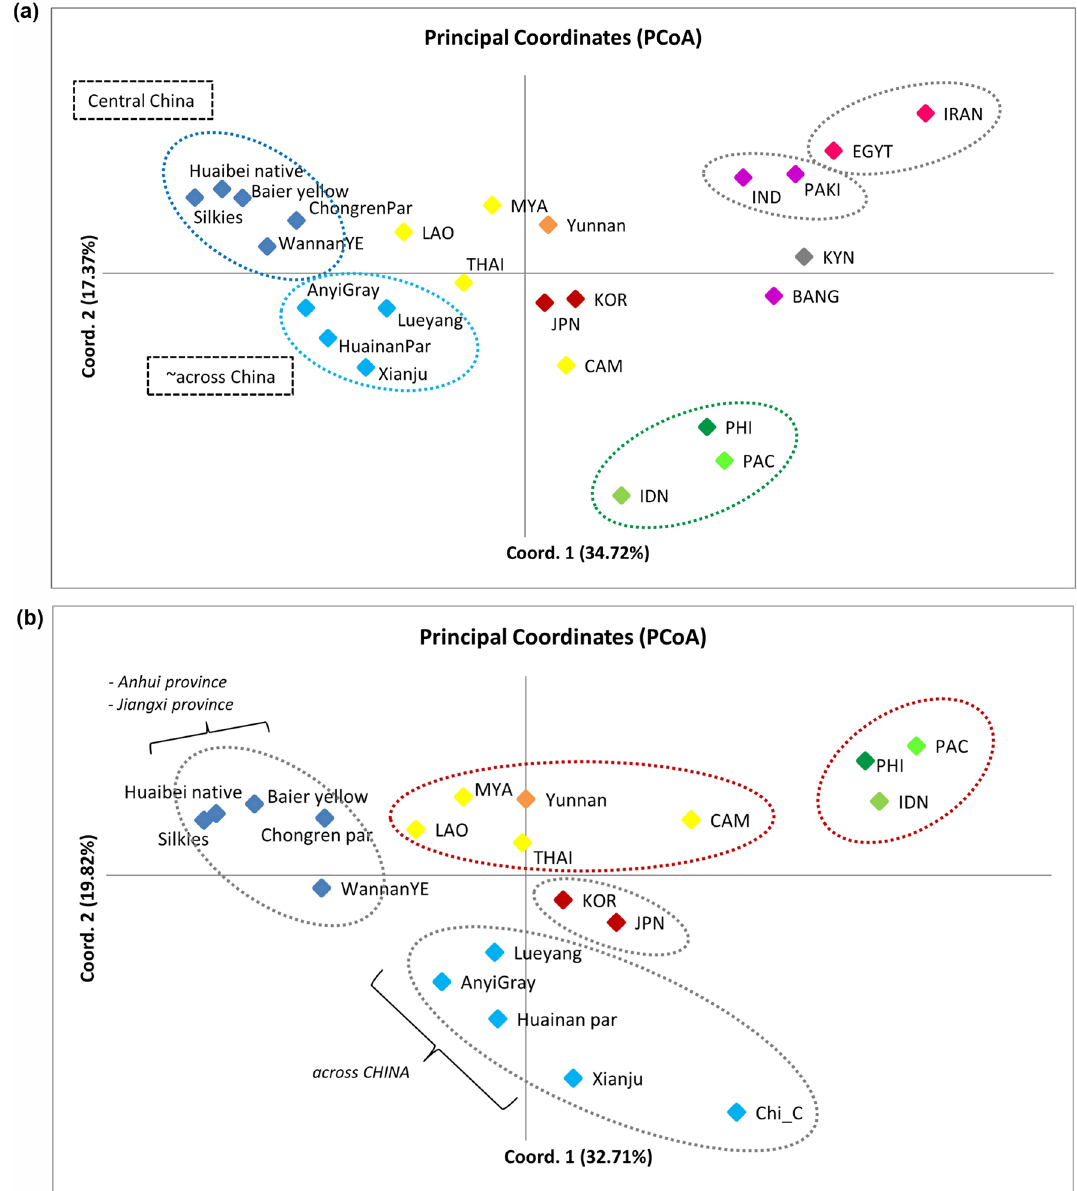
India), Africa (i.e., Egypt and Kenya), and Middle East (Iran). The geographic origins of populations are shown by different colors (yellow: MSEA, green: ISEA and Pacific, blue: China, red: Japan and Korea, purple: South Asia, pink: Egypt and Iran, and gray: Kenya). ( b ) PCoA plot of population pairwise F ST values of SEA and Pacific chickens after removing South Asian and Middle Eastern chicken